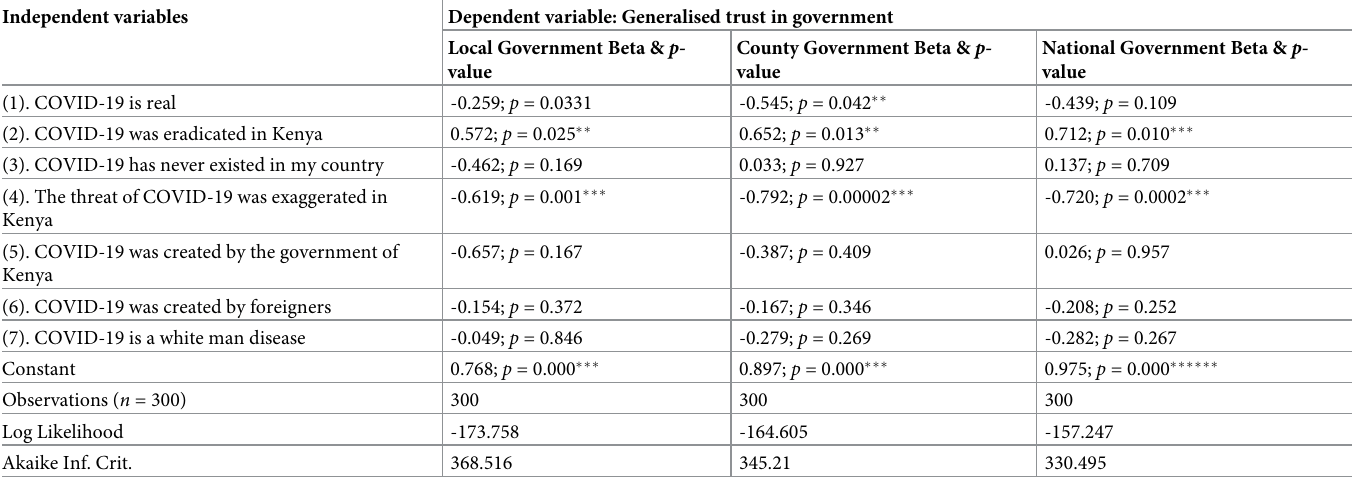
Table 3. COVID-19 conspiracy theories among self-confirmed CHVs (probit